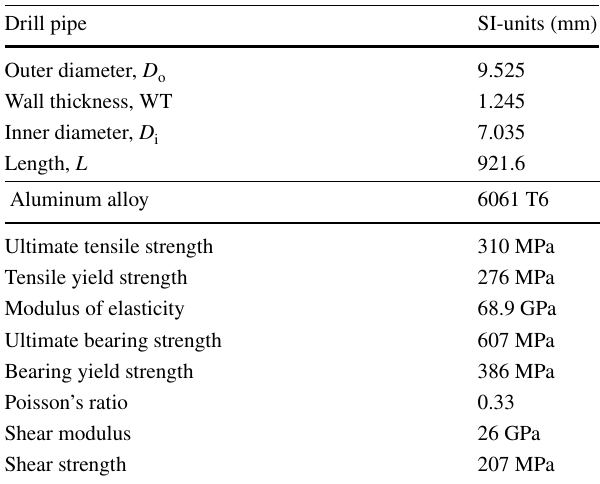
Table 1 Drill pipe specifications (Drillbotics) and mechanical proper- ties (ASM-Aerospace Specification Metals Inc.)